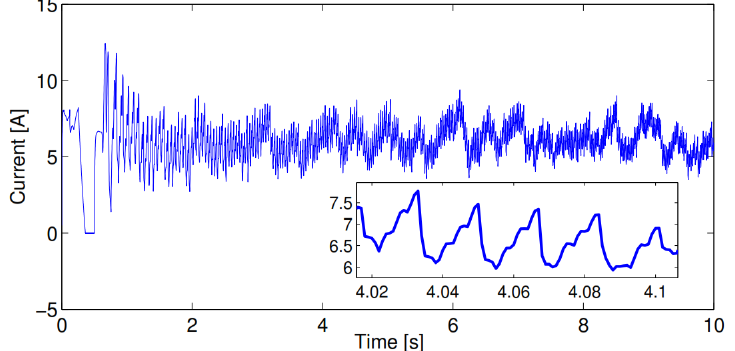
Figure 18. The optimal current delivered to the in-wheel AFSRM.